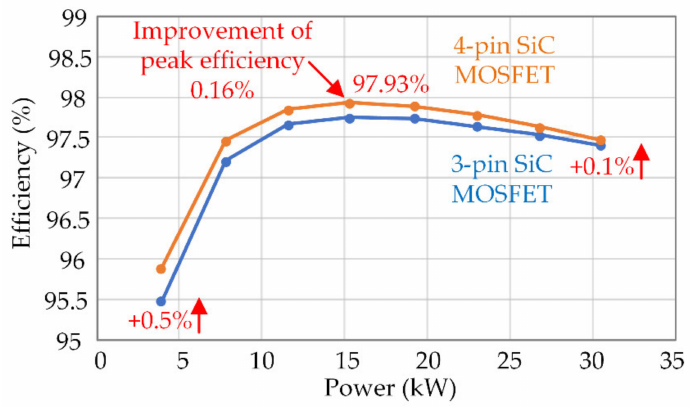
Figure 11. E ffi ciency curve of the all-SiC PWM